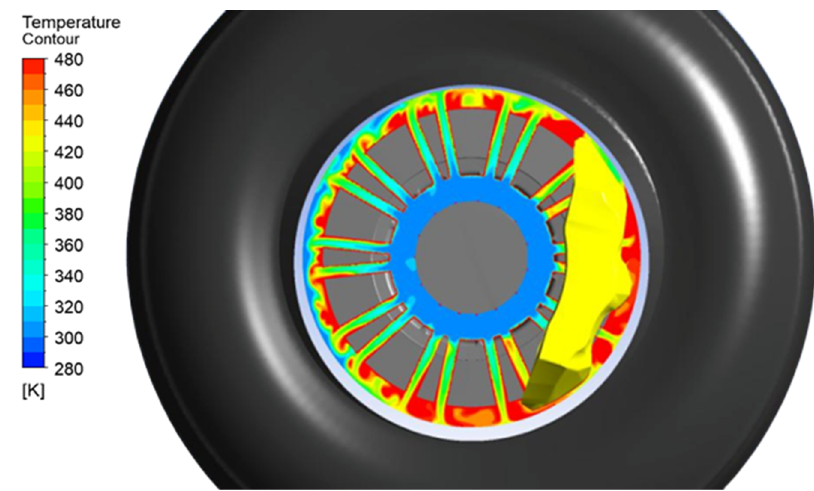
Figure 12. Temperature contours on the middle plane of the disk.